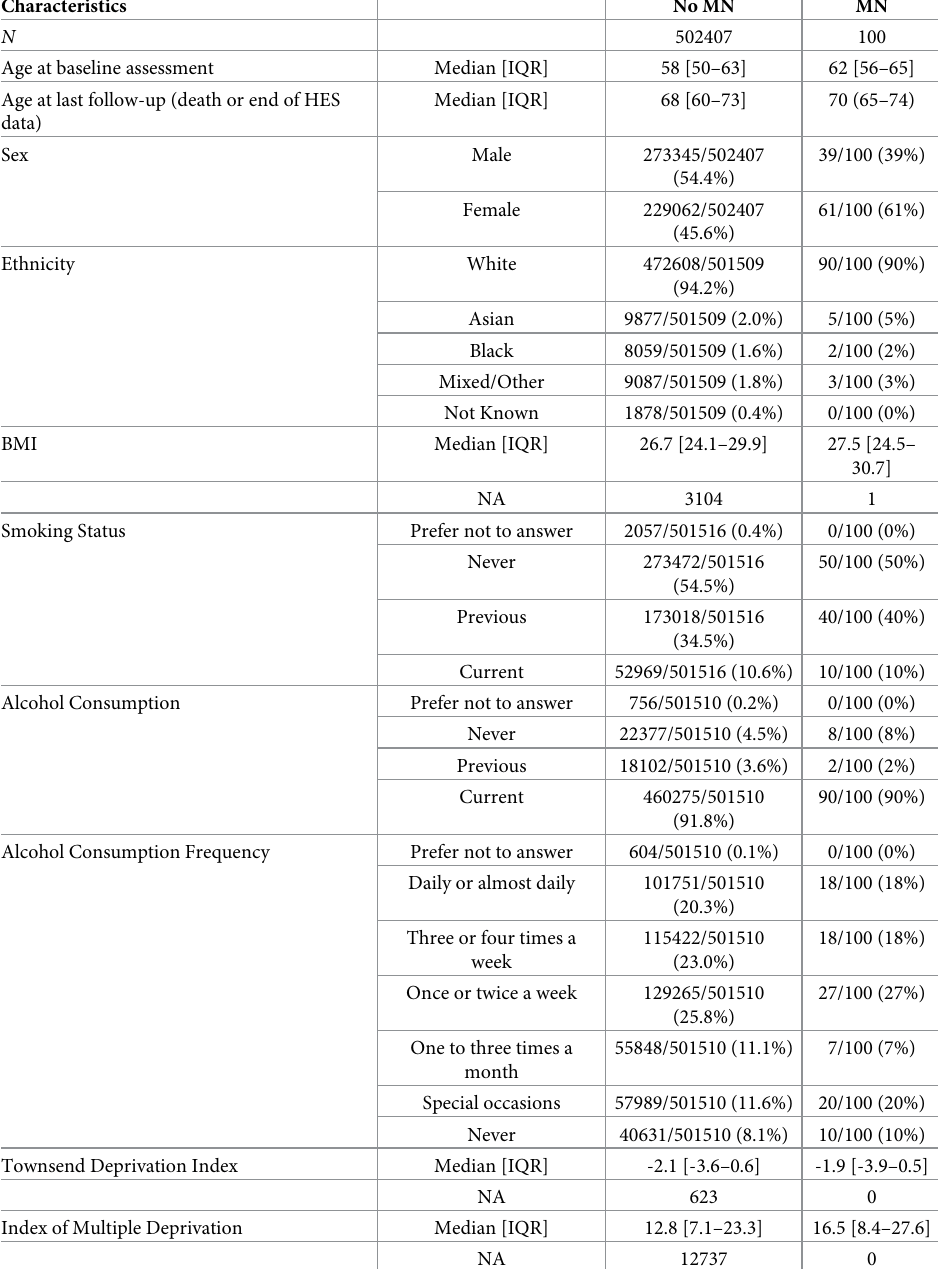
Table 2. Demographics for the UK Biobank population.